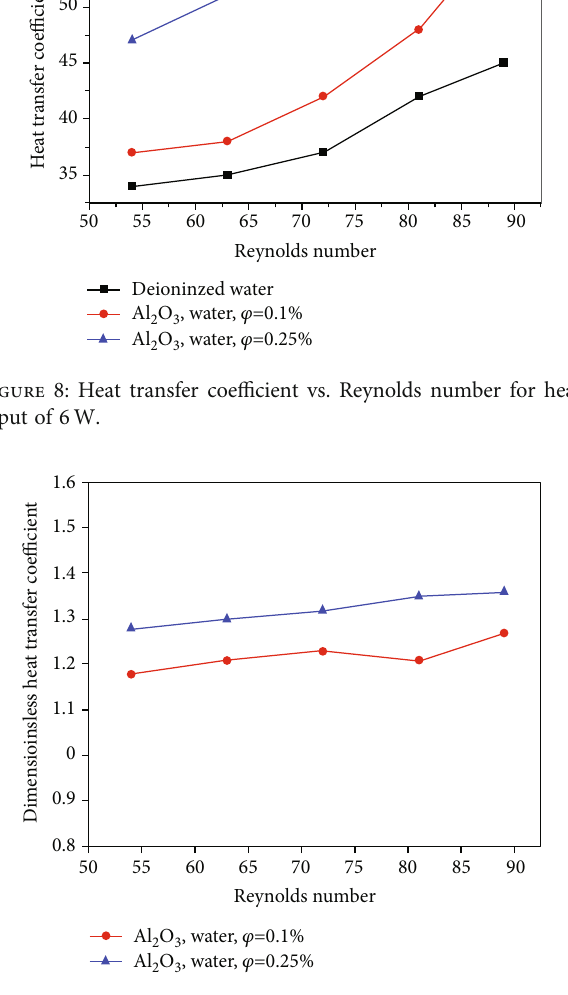
Figure 7: Heat transfer coe ffi cient vs. Reynolds number for heat input of 12 W.